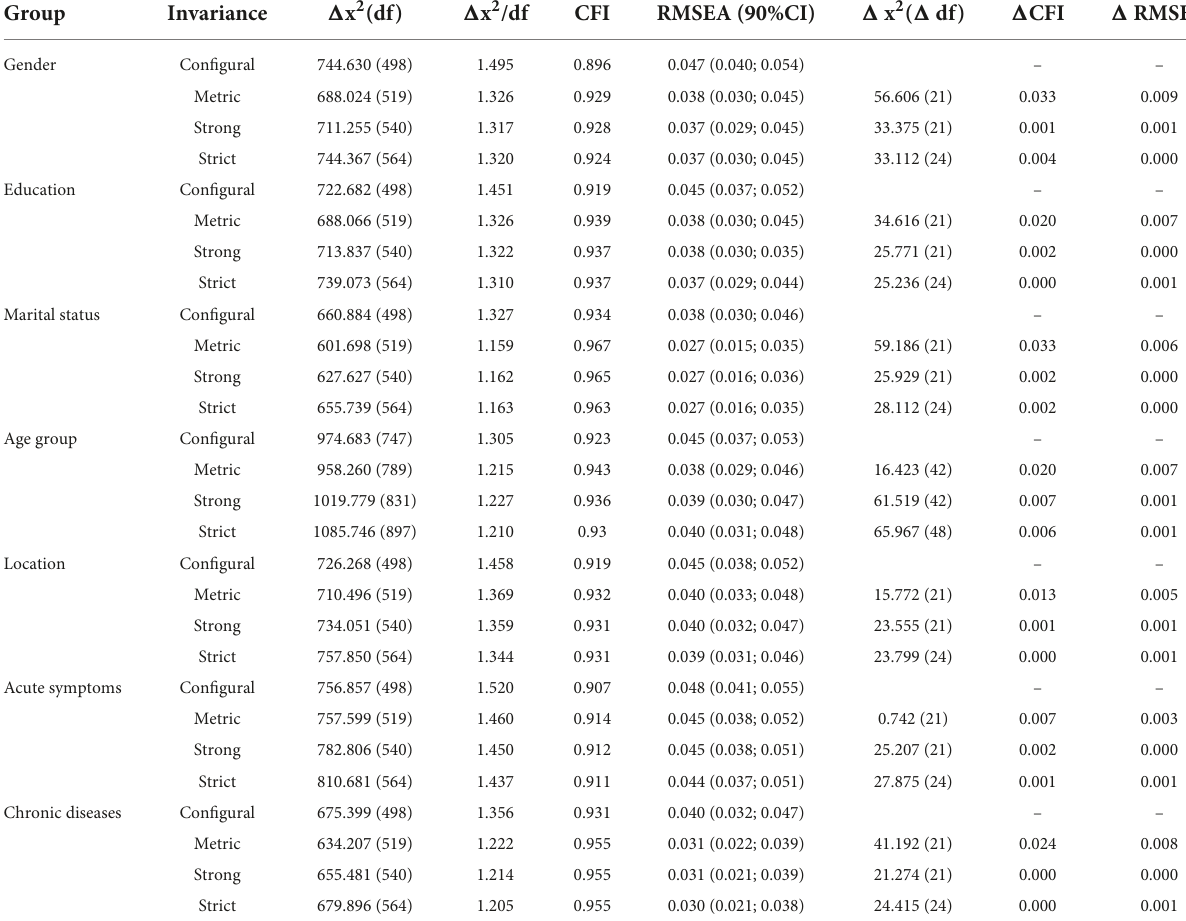
TABLE 8 Model fit and nested model comparisons for multiple group CFA